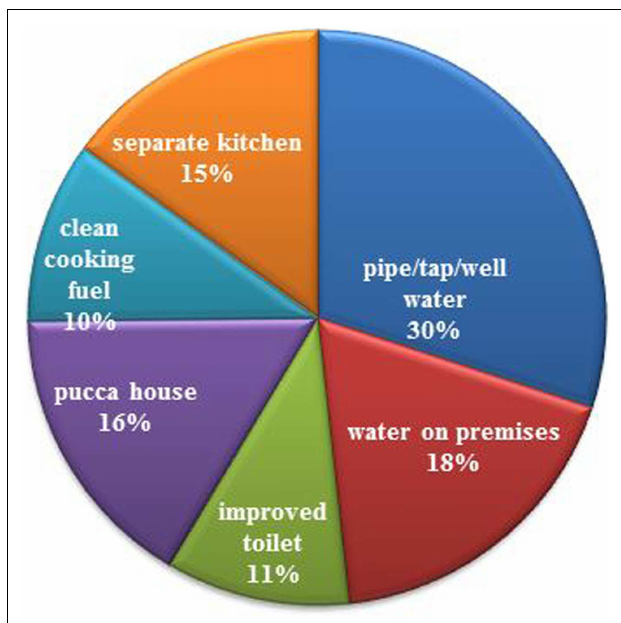
FIGURE 2 | Percentage of households by built environment .